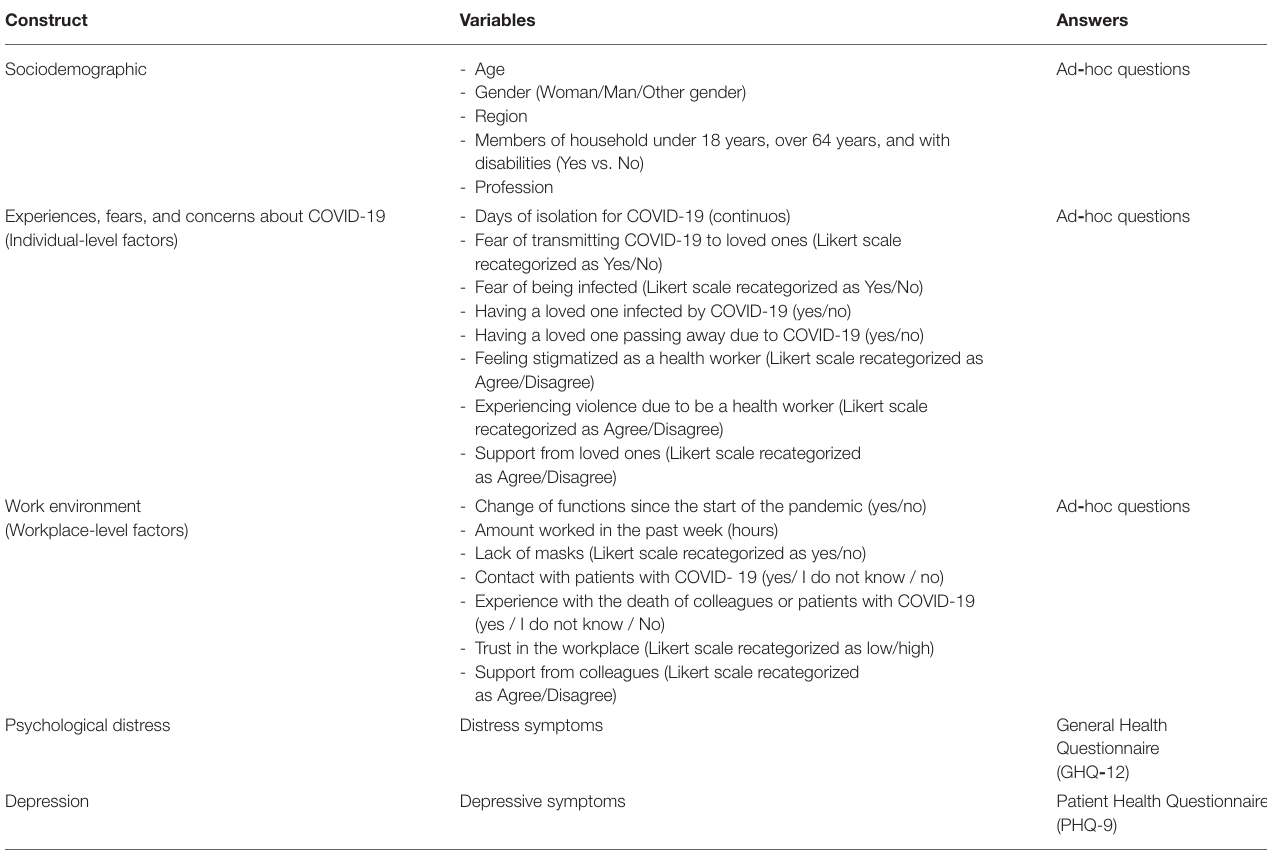
TABLE 1 | Variables from the HEROES questionnaire used in this study.